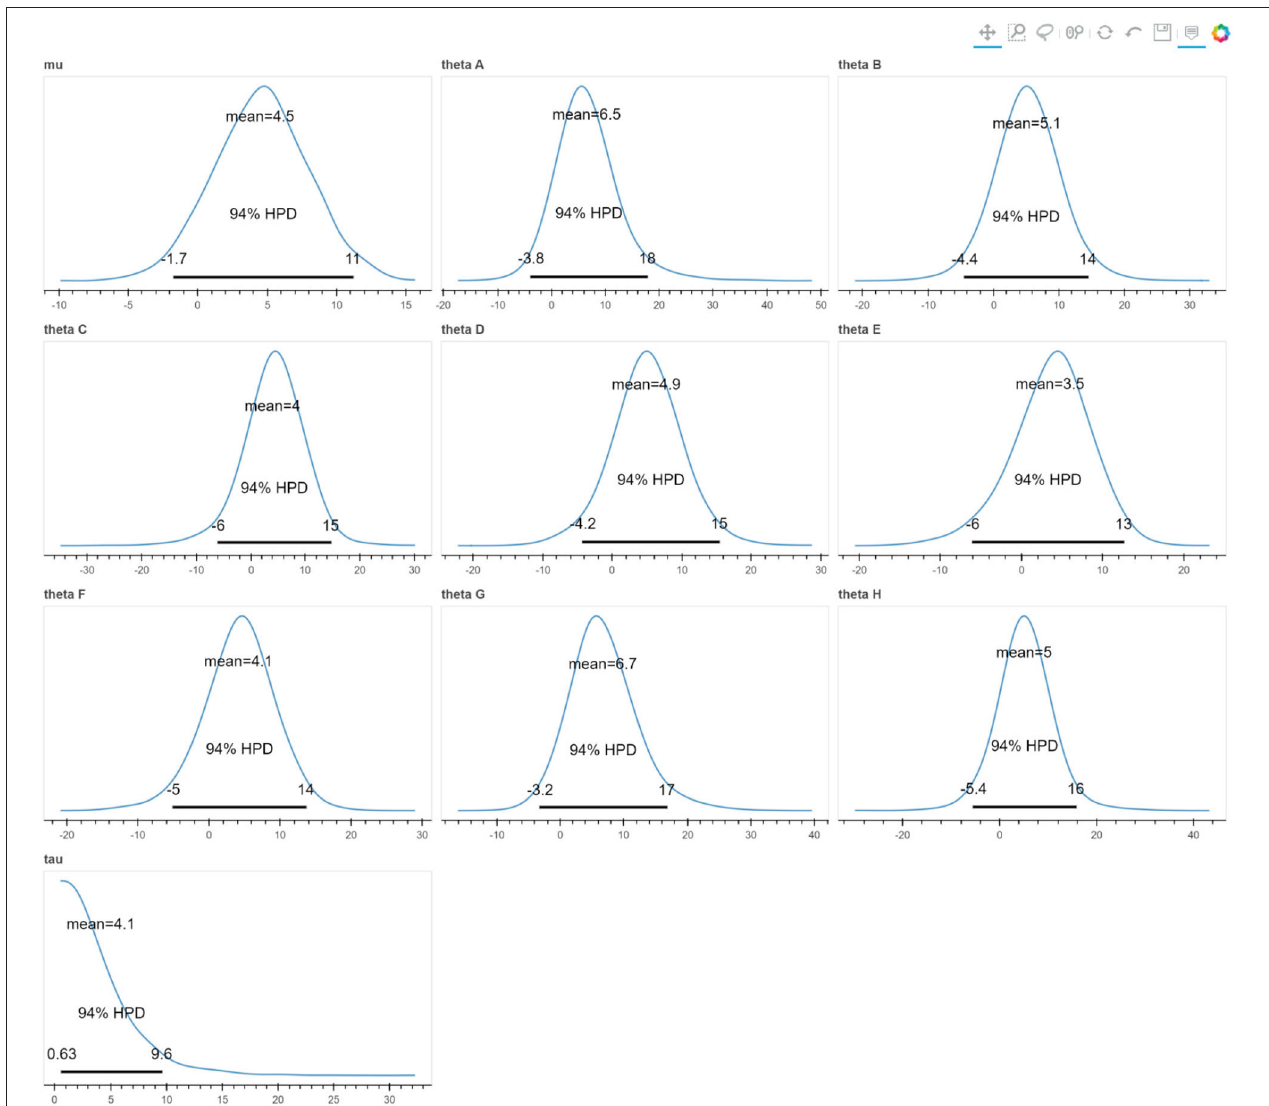
FIGURE 5 | The posterior densities of the centered hierarchical model of the eight schools problem presented in the style introduced by Kruschke (2015). Although, this is a rather simple model, we can see that it can produce ten different uncertainty visualizations. This number could rise even more if the parameters of the model had more (multi-valued) indexing